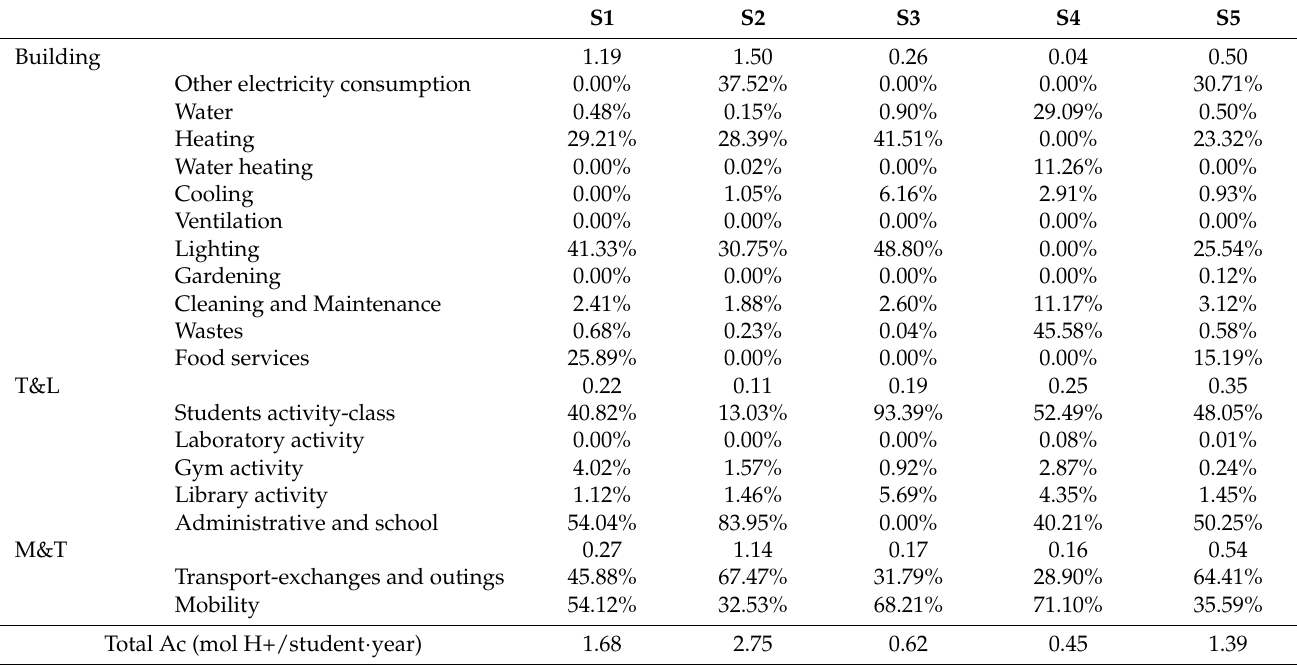
Table 10. Acidification impacts results per school, subsystem, and